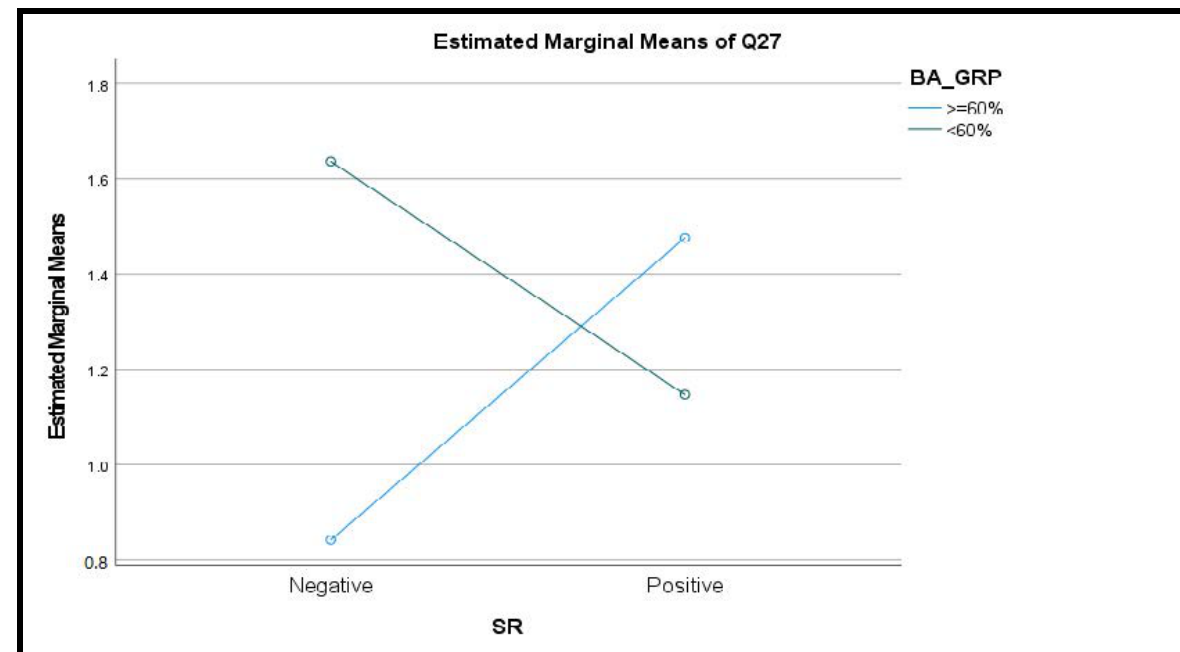
Figure 1. Interaction between SR and BA groups with regard to biting, chewing or playing with the tongue, cheeks or lips.